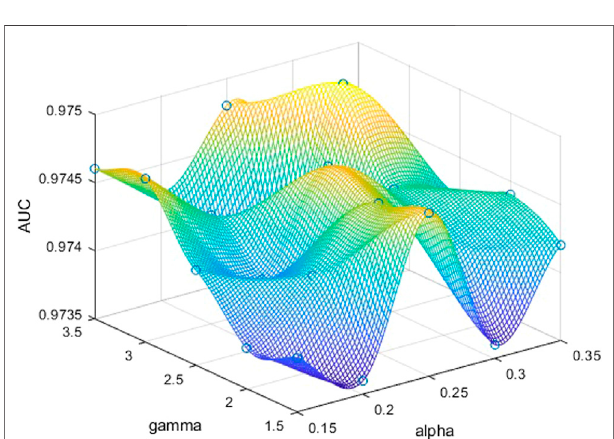
FIGURE 9 | AUCs obtained by binary focal loss on DRIVE according to different α and γ . We can obtain the best performance when α is 0.3 and γ is